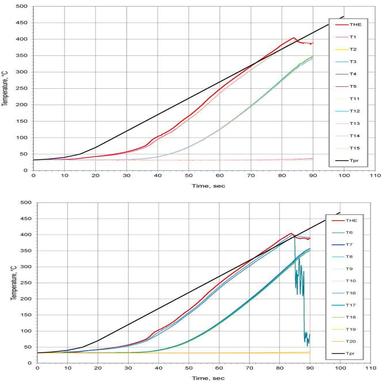
Temperature/time curves recorded during test A (up) and B(down) for base coated (thermocouples T1-T10) and nano-coated (thermocouples T11- T20) material.